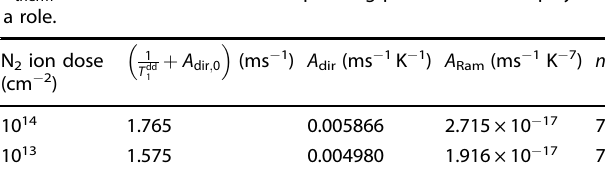
Table 1. Parameters of Eq. (3) for divacancy spin in 4H-SiC implanted with different doses of nitrogen molecule ion in ref. 58 . A Orb , A loc , and A therm are set to zero as the corresponding processes do not play a